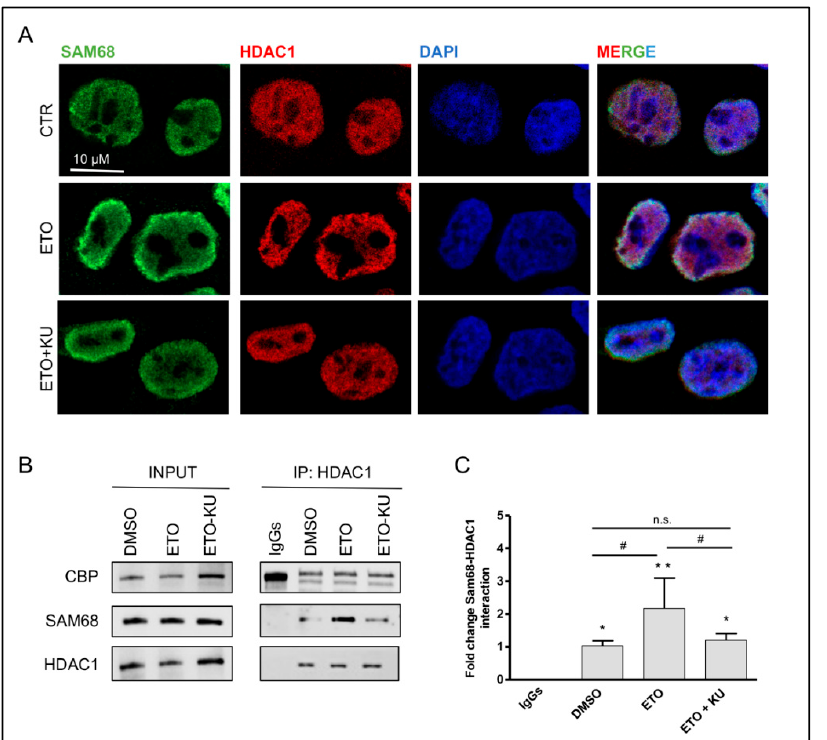
Figure 4. Sam68 and HDAC1 participate in the DNA damage response. ( A ) Immunofluorescence analysis was performed on TC-71 cells treated with either DMSO, 5 µM etoposide (ETO), or etoposide with pre-treatment of 10 µM of KU55933 (ETO + KU). ( B ) Western blot analysis of co-immunoprecipitation experiments performed from nuclear extracts of TC-71 cells treated with DMSO (vehicle), 5 µM etoposide (ETO), or etoposide with pre-treatment of 10 µM of KU 55,933 (ETO + KU). HDAC1 protein was immunoprecipitated with a specific antibody; CBP protein was used as the positive control. Sam68 was detected in the immunoprecipitated proteins. ( C ) Histograms represent the densitometric analysis of Sam68-HDAC1 interaction in each condition relative to DMSO, from three independent experiments. Statistical analysis was performed by ANOVA with the Bonferroni post hoc test. p -value (*, # <0.05, ** <0.01, n.s. >0.05).